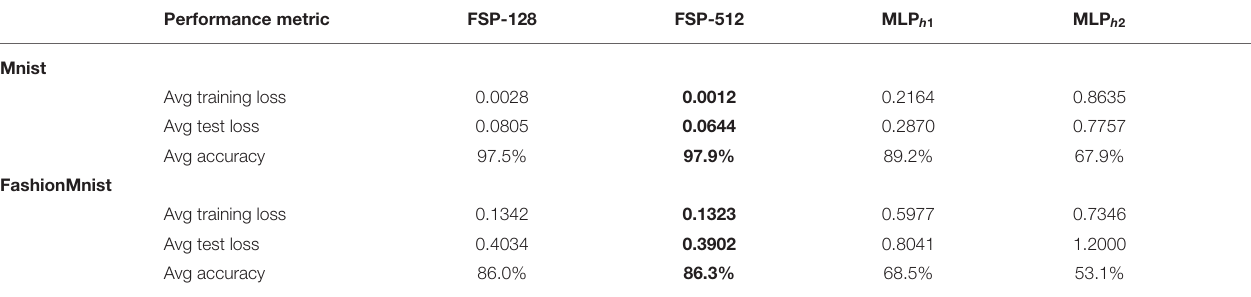
TABLE 10 | Performance metrics by training different architectures on the MNIST and FashionMNIST